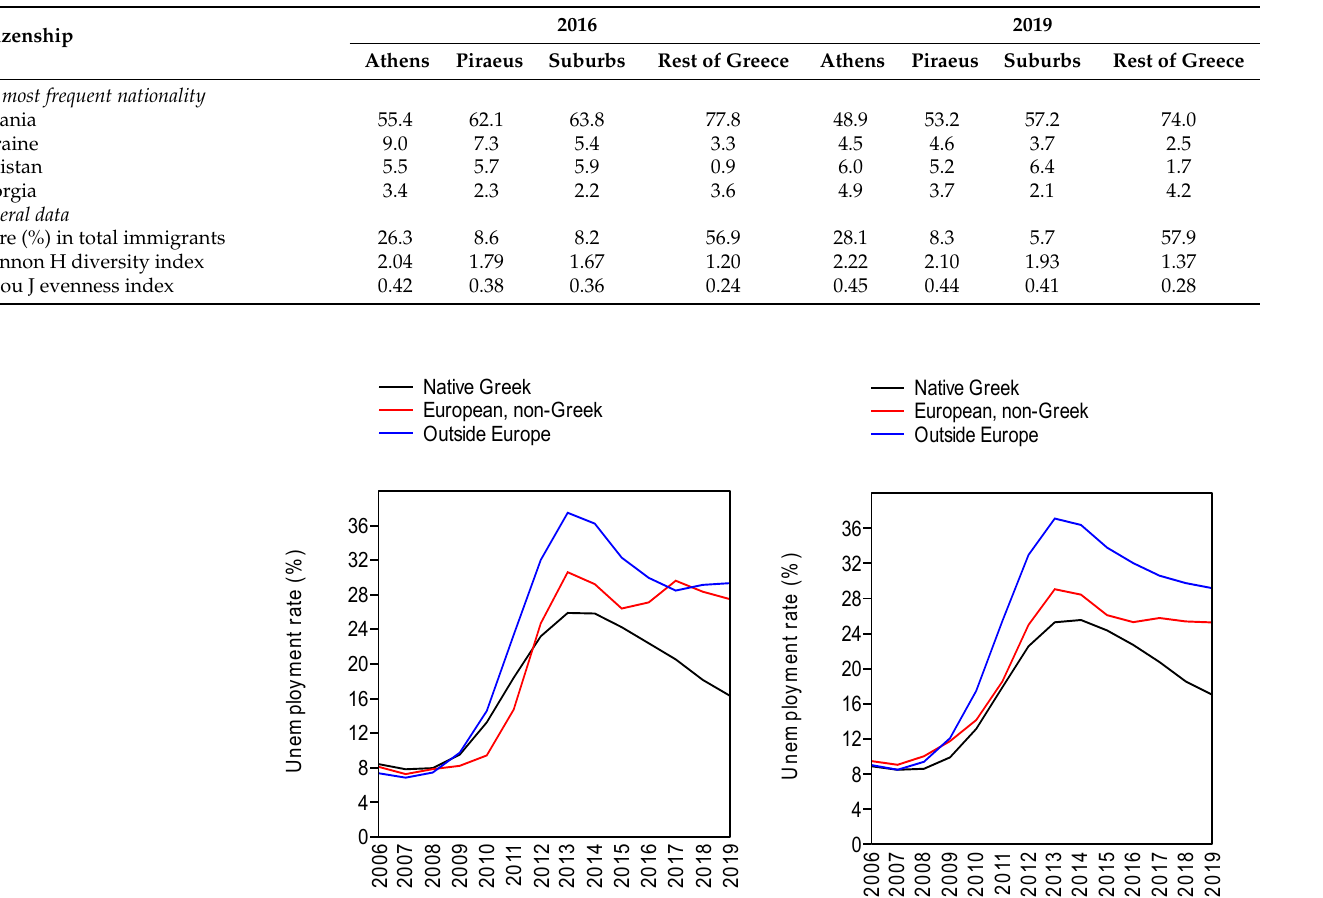
Table 2. Statistics of the requests of residence permits by year, citizenship, and district in Greece.